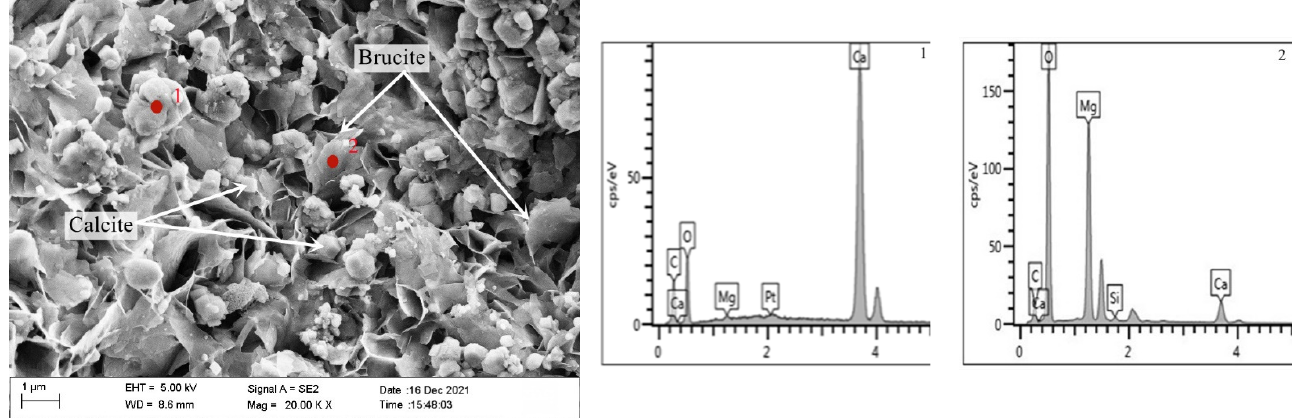
Figure 10. SEM-EDS image of the product in fracture surface of aggregate S1# in the concrete microbars cured in 1M NaOH solution at 80 °C for 28 days.